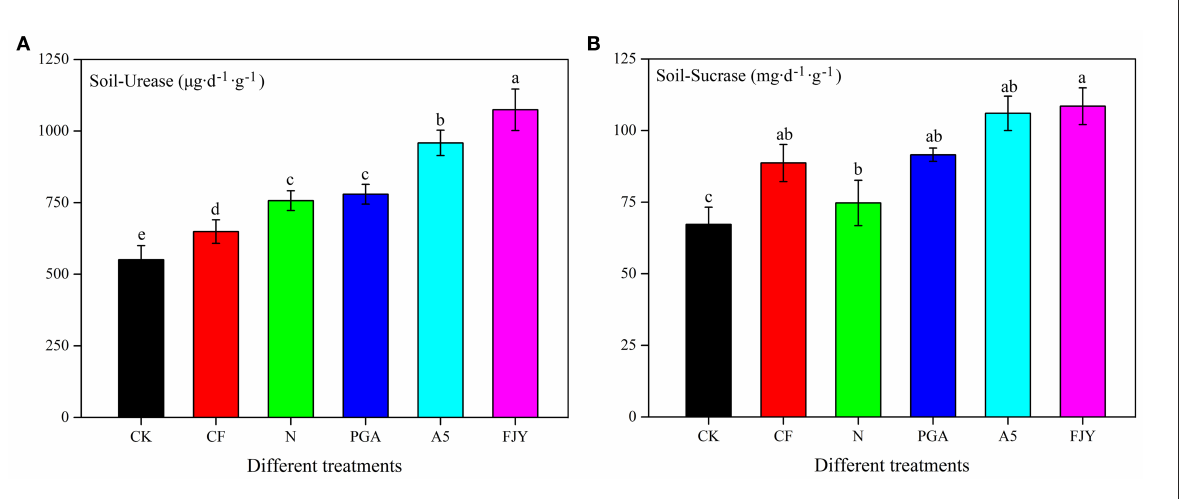
FIGURE1 Effects of different treatments on urease activity (A) and sucrase (B) in the rhizosphere